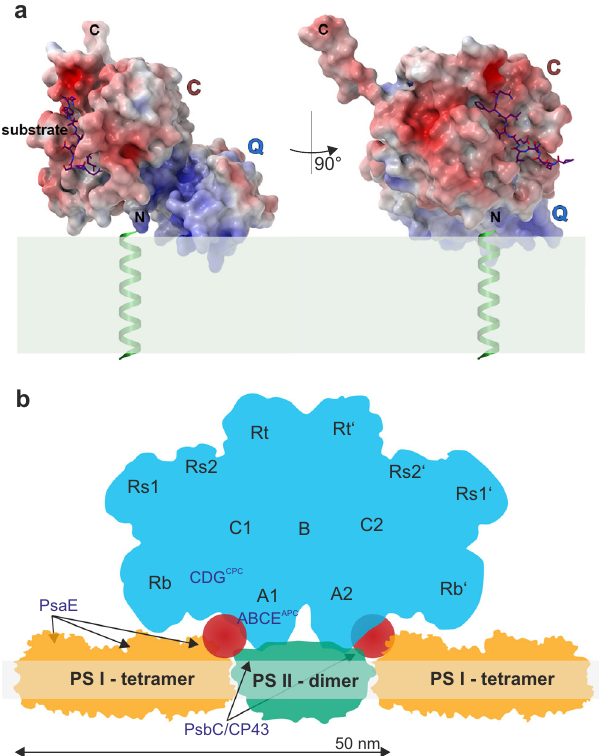
Fig. 9 Model of ana Cyp40 at the membrane and hypothetical functional models. a Ana Cyp40 Δ TM is placed on the membrane (green) in that way that the positively charged surface of the Q-domain interacts with the membrane lipids. In this orientation the N-terminus is close at the membrane, so that the trans membrane helix in the full-length ana Cyp40 can be attached to the N-terminus of ana Cyp40 Δ TM. In this orientation also the substrate binding site is accessible for the substrate of ana Cyp40. b The structure of the tetrameric PSI 71 , the dimeric PSII 72,73 and the PBS 74 as well as the information on the positioning of the PBS with respect to PSII 74 was used to create a model for the positioning on/in the thylakoid membrane. The different domains of the PBS (black letter) and the positioning of the proteins found to complex with ana Cyp40 (purple letter) are indicated. The red circles indicate the maximal dimension of the soluble domain of ana Cyp40 that would fi t into the cavity in the PBS between PSII and PSI according to the fi rst hypothetical functional model. Note: PBS-PSII- PSI megacomplex formation used here to illustrate a putative function of ana Cyp40 is only one mode of complex organization at membranes as current results point toward a fl exible arrangement. Hence, reader should keep in mind that this is only one possible residues in these long loops, no electron density is present. Moreover,